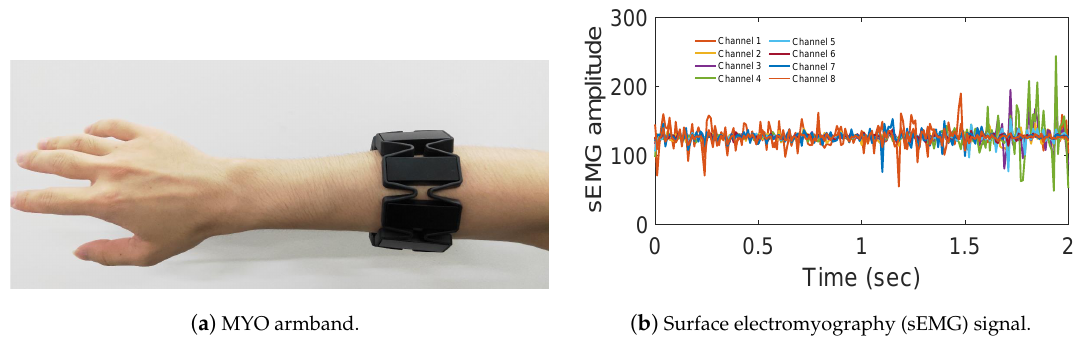
Figure 1. Detection of sEMG signal by using the MYO armband [22].